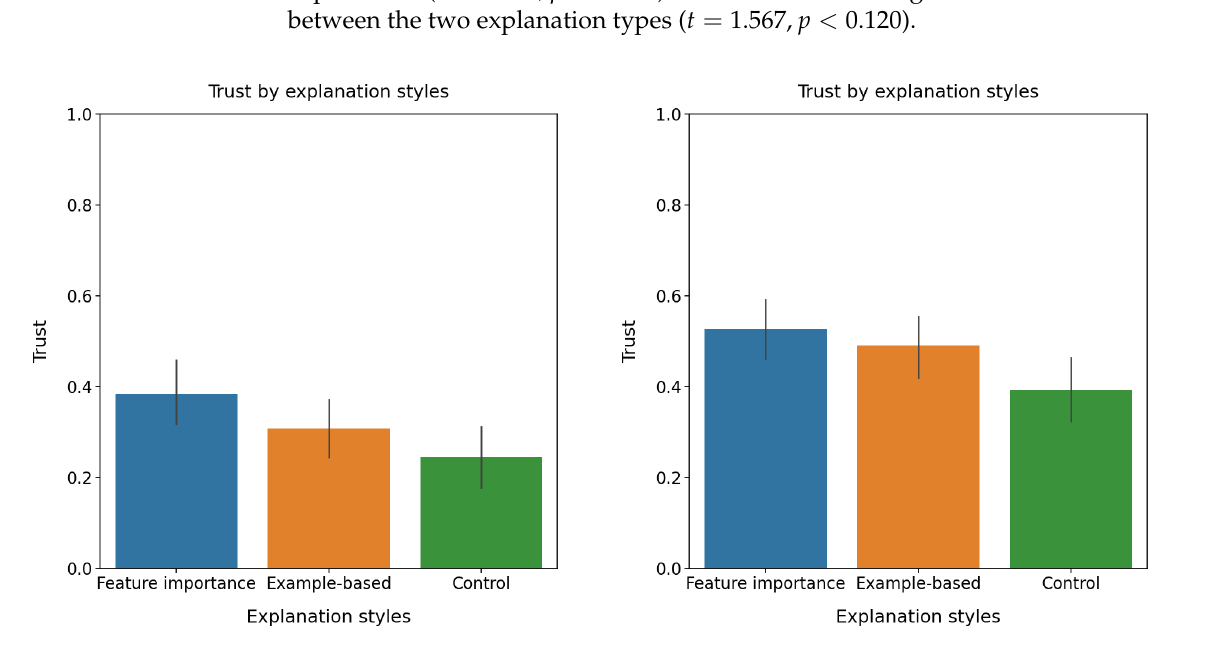
Figure 5. Effects of explanation on user trust under different fairness levels. ( a ) effects of explanation on user trust under low introduced fairness level; ( b ) effects of explanation on trust under high introduced fairness